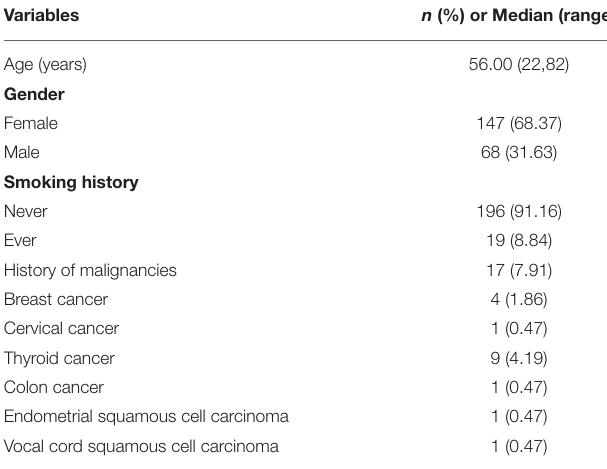
TABLE 1 | Patient characteristics on a per patient